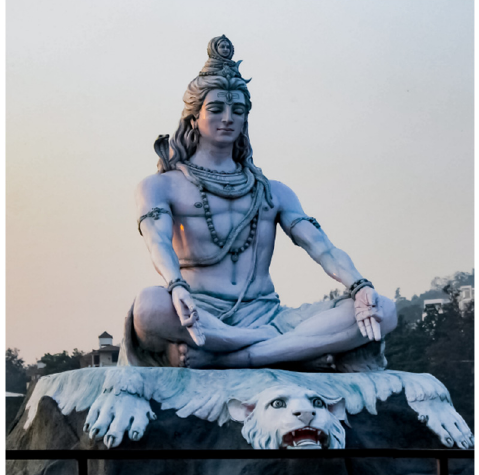
Figure 5. Here Ś iva as the ideal experiencer is seated in meditation (picture by Sandeep Singh, Canva ). He embodies the virtues of the ideal experiencer, unphased by turbulent events. Also, Ś iva brings about good outcomes by way of meditative experiencing. For instance, the space around him in meditation is serene. Those who awaken Ś iva from meditation are said to be burnt by a flame that originates from his third eye.